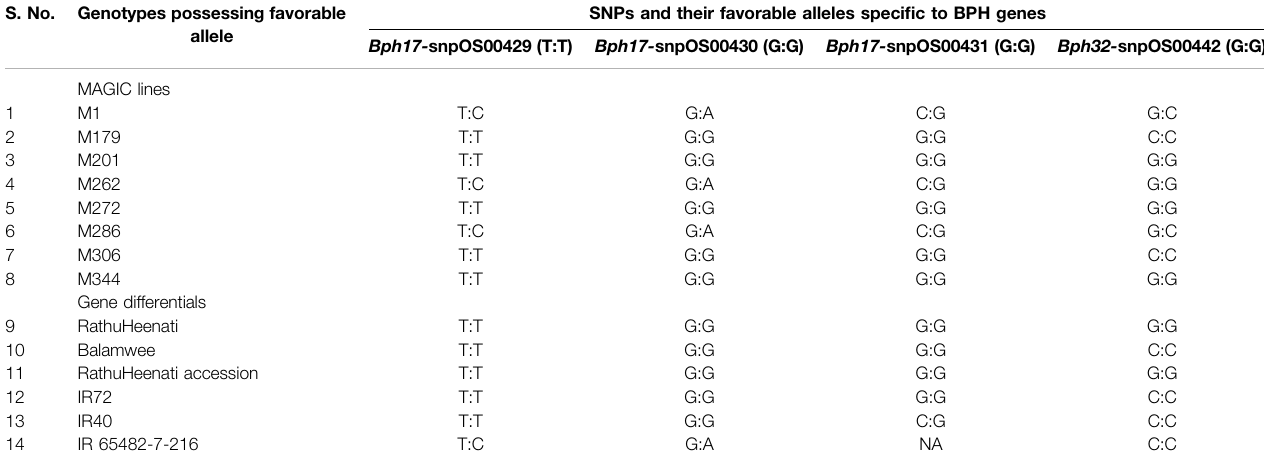
TABLE 8 | List of functional SNPs and favorable alleles speci fi c to Bph17 and Bph32 genes validated in the panel of genotypes. S. No. Genotypes possessing favorable SNPs and their favorable alleles speci fi c to BPH allele